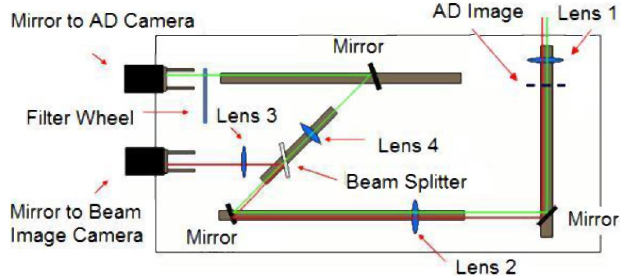
FIG. 2. (Color) Optical layout.